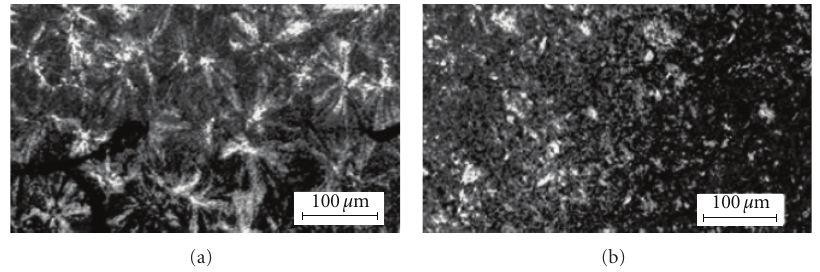
Figure 1: Structure of unfilled PP (a) and filled PP with 40% of MICA-SOFT (b) under optical microscope.